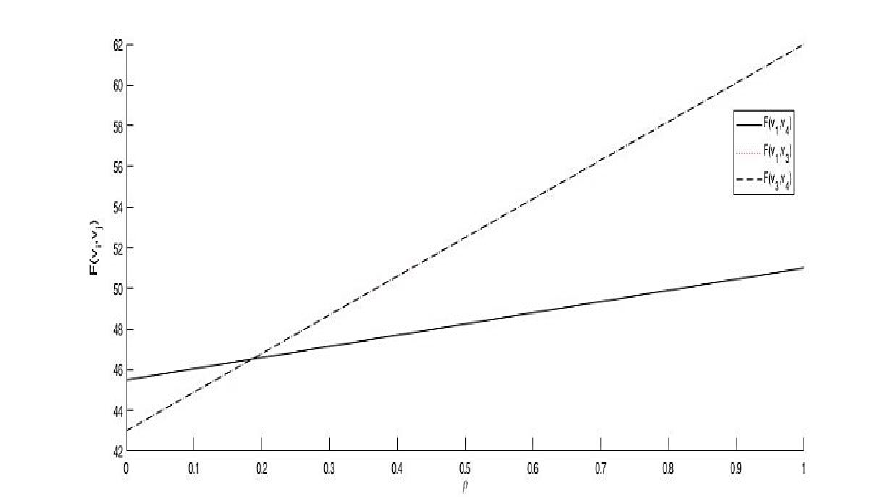
Fig. 2. The value of objective functions in example 1 respect to 𝟎 ≤ 𝝆 ≤ 𝟏 .